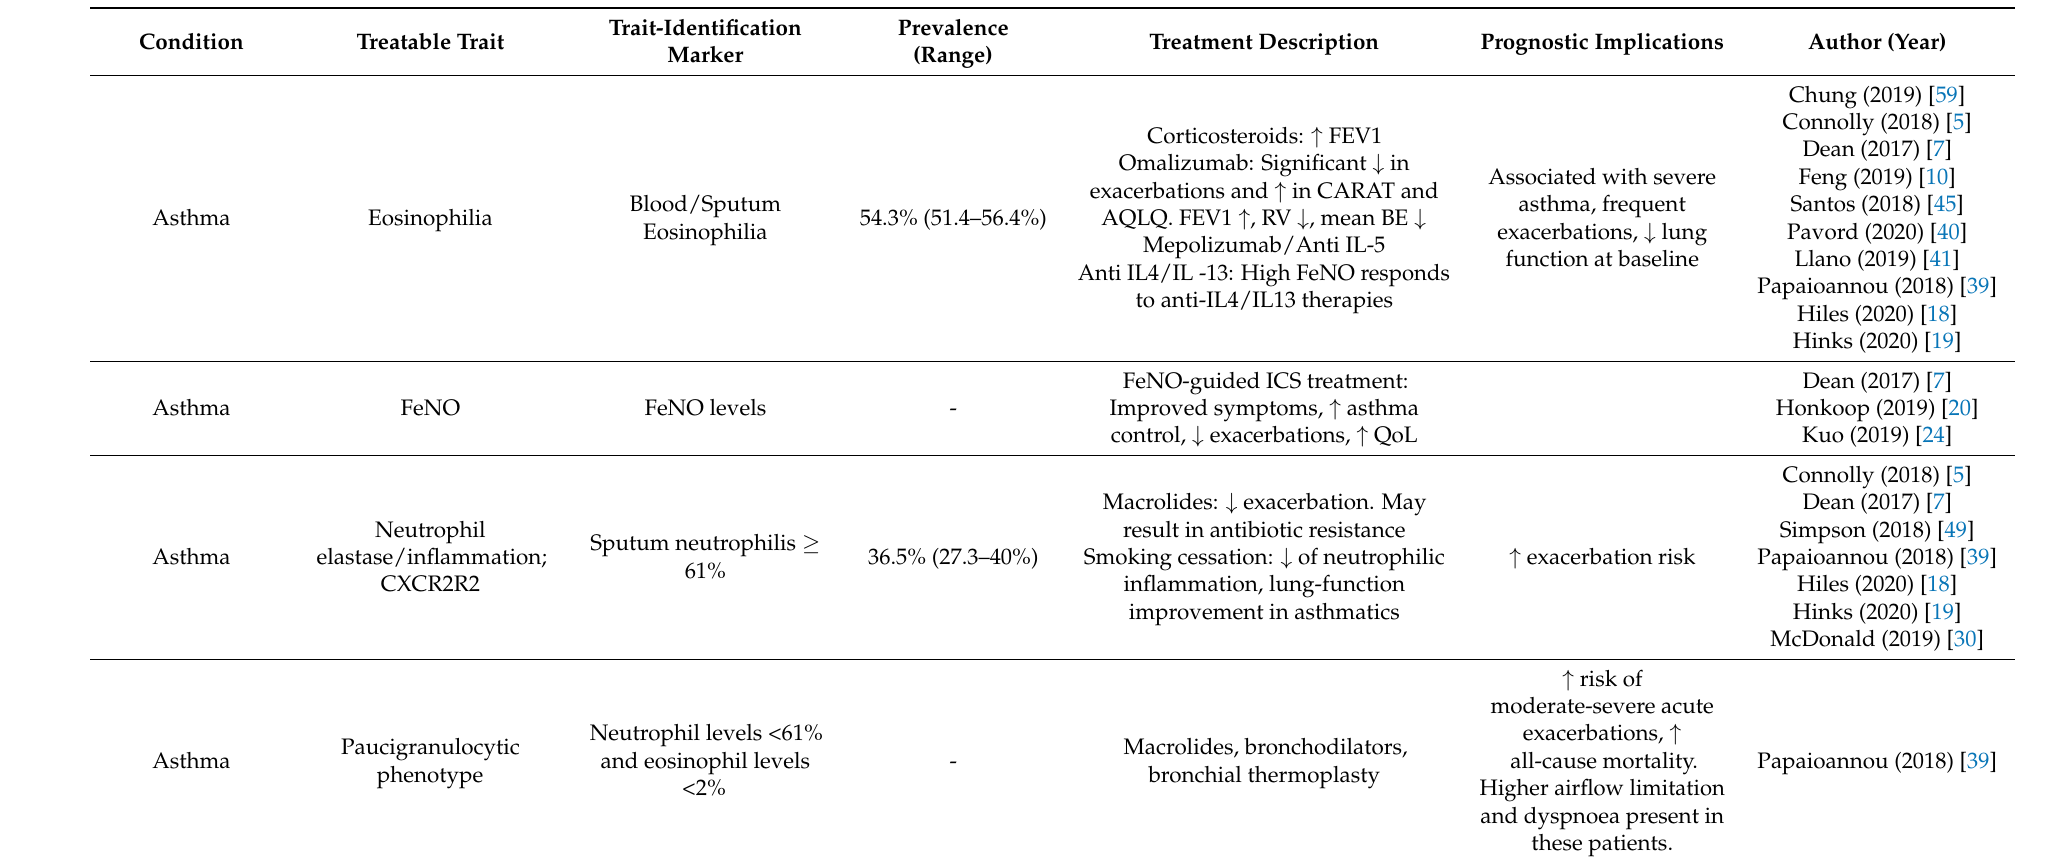
Table 3. Overview of biochemical treatable